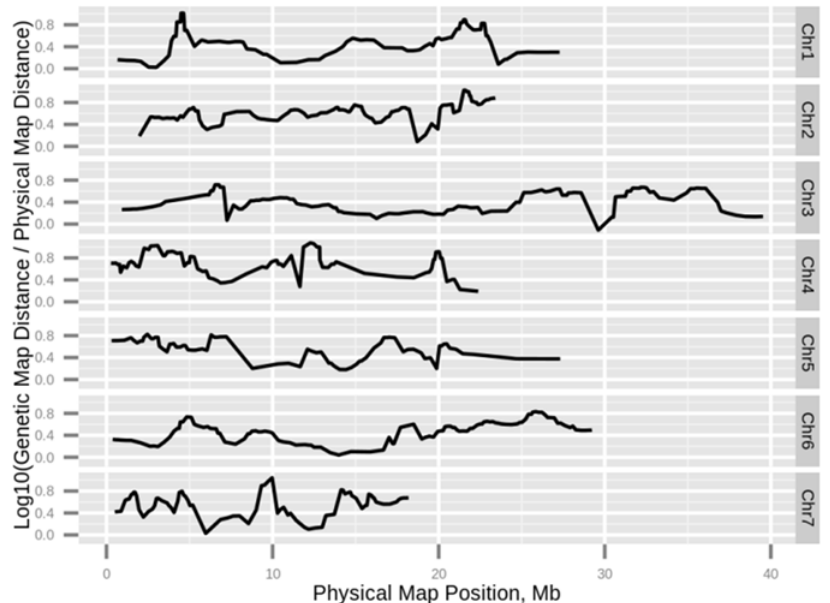
Fig 4. Regional recombination rate. For each chromosome, a sliding window was run over 5 SNP markers on the genetic map. Within that window, the slope of the genetic distance (cM) vs. physical genomic distance (Mb) was calculated and plotted on a log scale. Markers whose order on the genetic map was inconsistent with their order on the genome were removed. The recombination rate was calculated for the 'Gy14' genome.